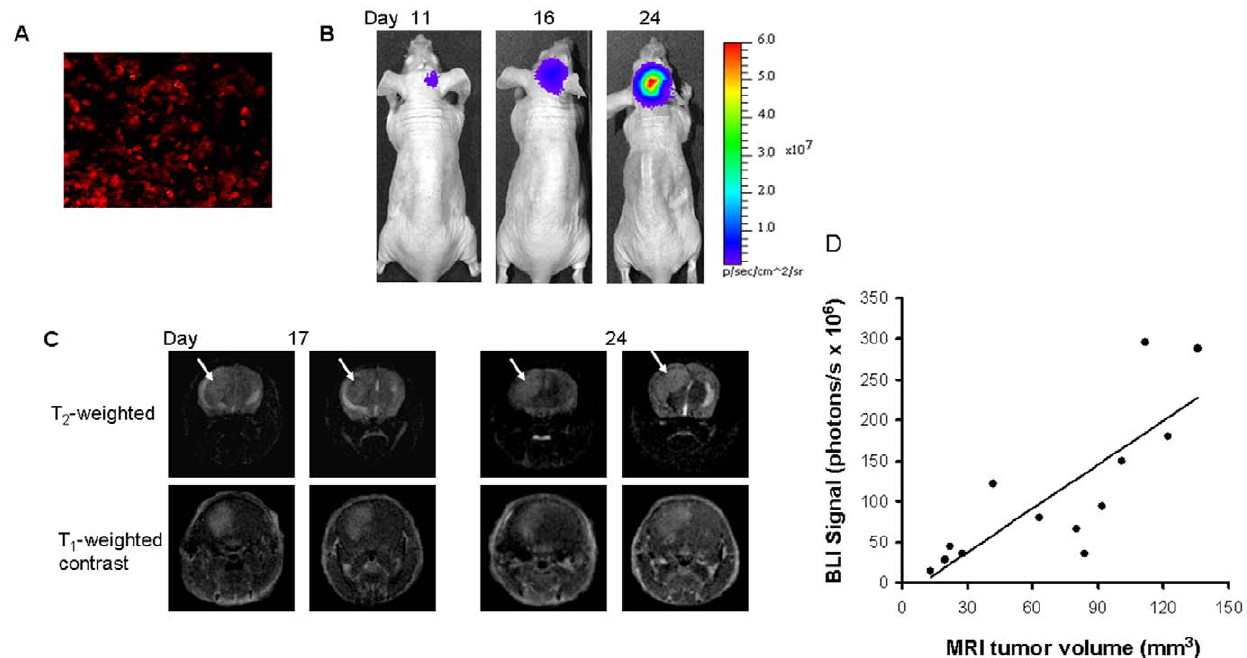
Figure 1. BLI and MRI monitoring of intracranial growth of U87 glioma in a mouse. A . Immunostaining with anti-luciferase antibody showed extensive expression of luciferase in tumor tissues. B . BLI showed increasing light intensity in the mouse brain over time. C . Transaxial MRI detected an intracranial tumor on consecutive slices (arrows) based on both T 2 - weighted and T 1 -weighted contrast enhanced MRI, which was found to grow in size on the follow-up study (84 mm 3 on day 17, 136 mm 3 on day 24). D . A good correlation between the BLI signal and actual intracranial tumor volume was observed (r=0.8, p , 0.05).